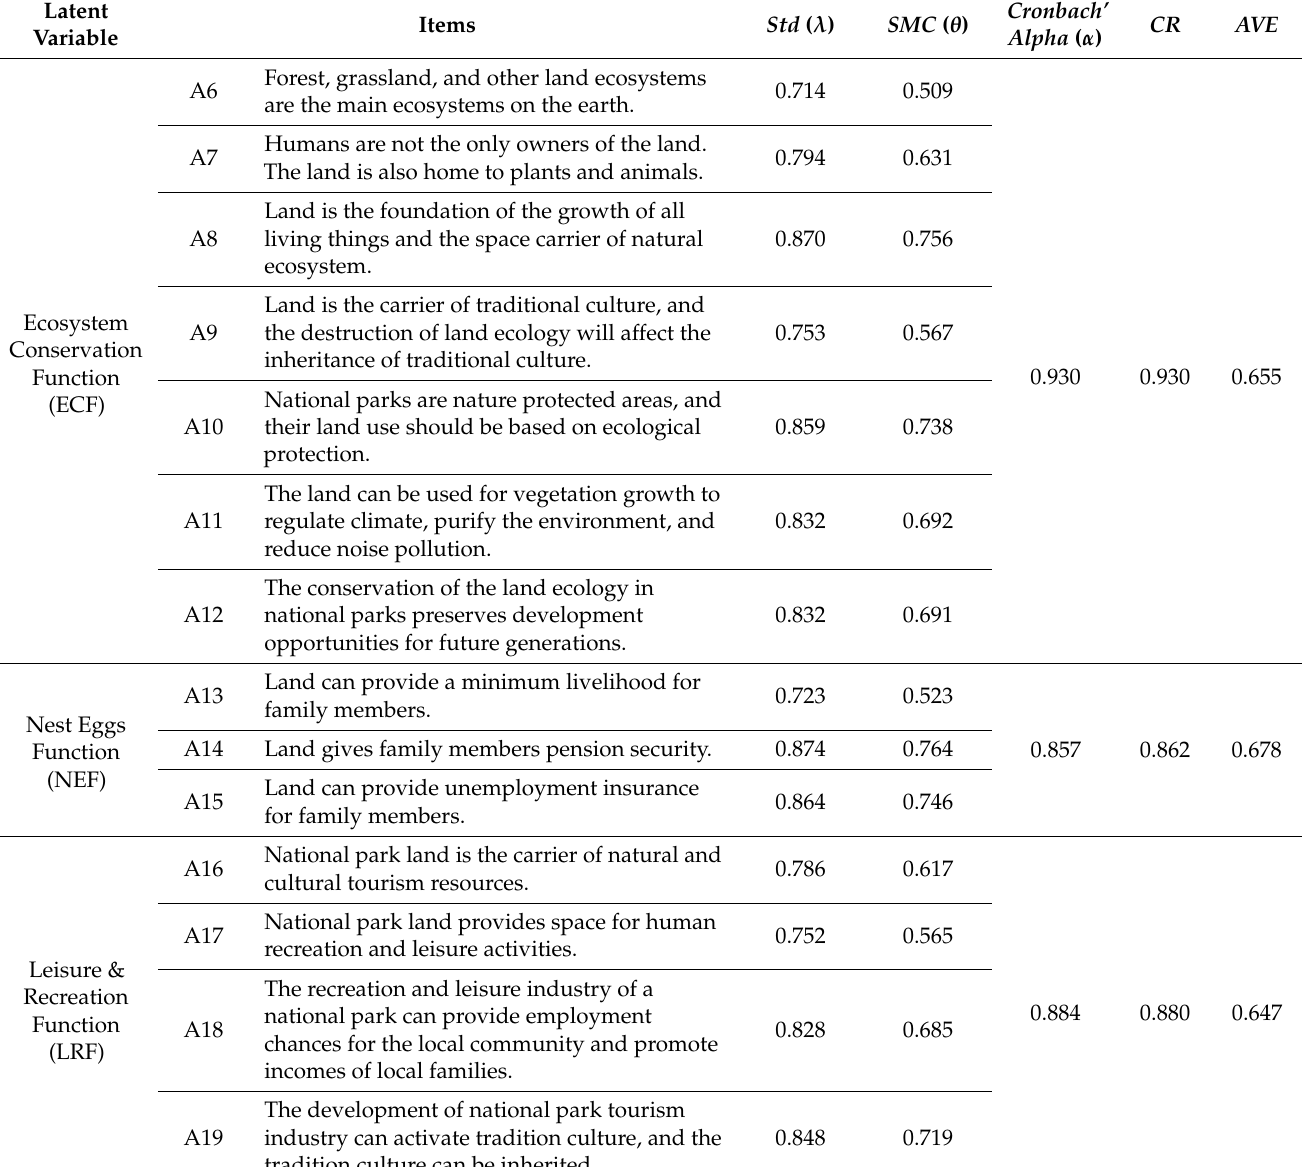
Table 1. The CR and AVE of the scale based on